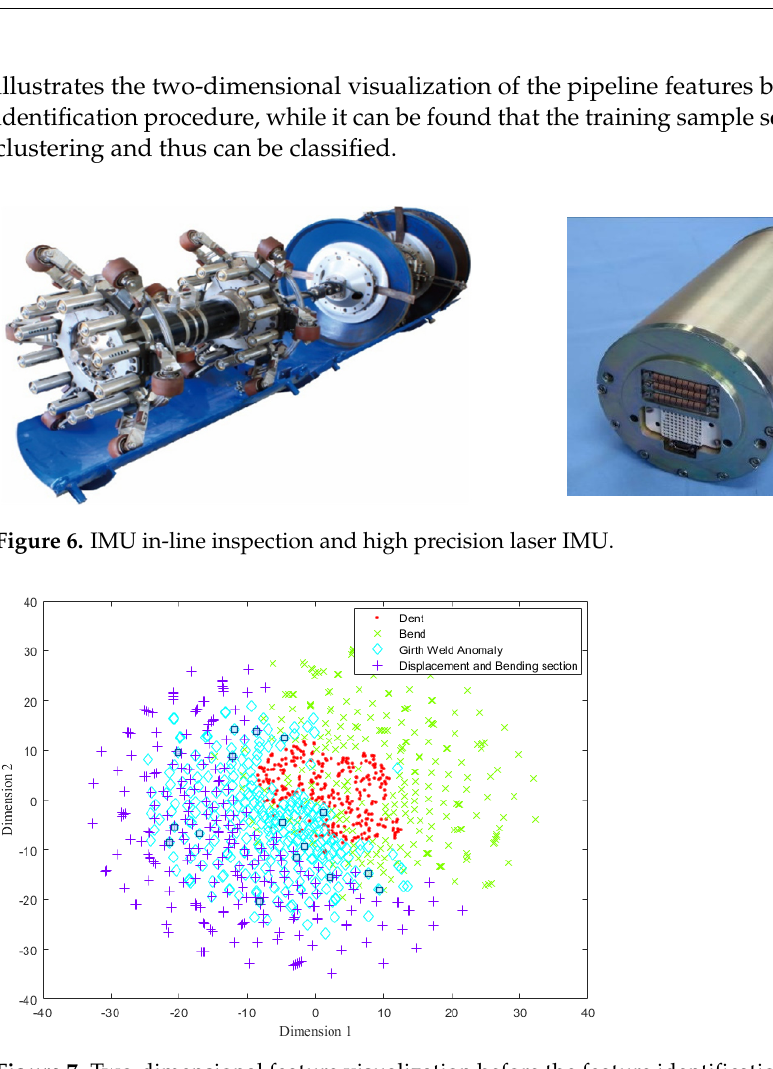
Figure 7. Two-dimensional feature visualization before the feature identification process.